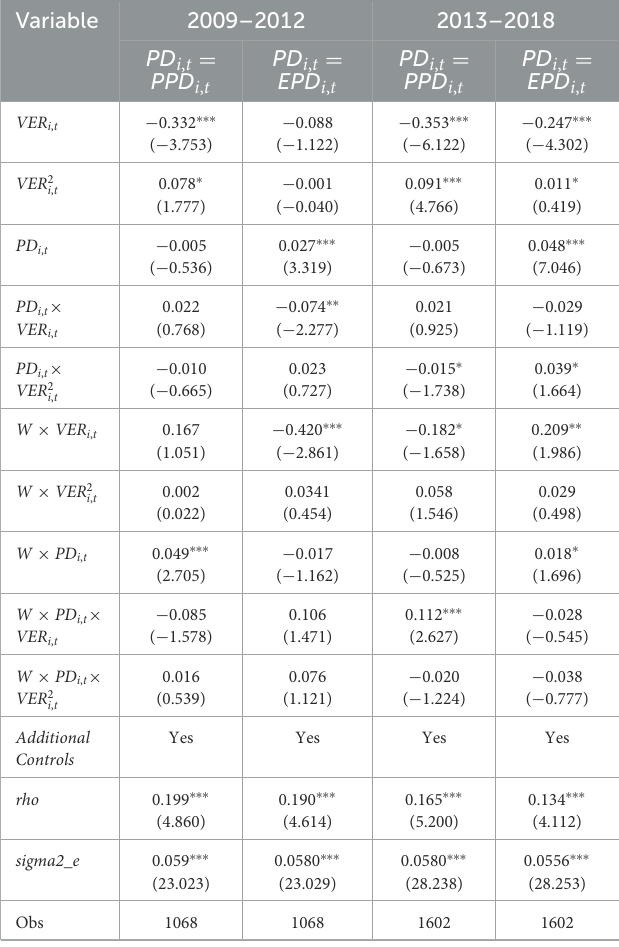
TABLE 11 Test results of moderating effect of PD on green governance effect of VER in different time periods.